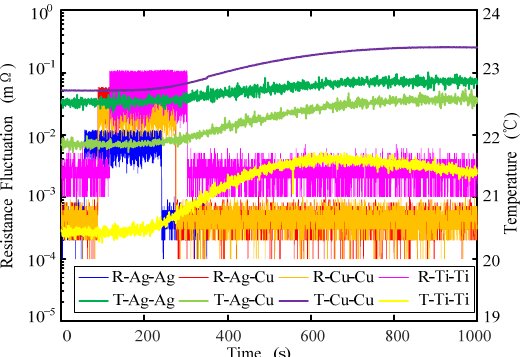
Figure 12. Dynamic contact resistance changes in fluid rings of electrodes made from different materials.